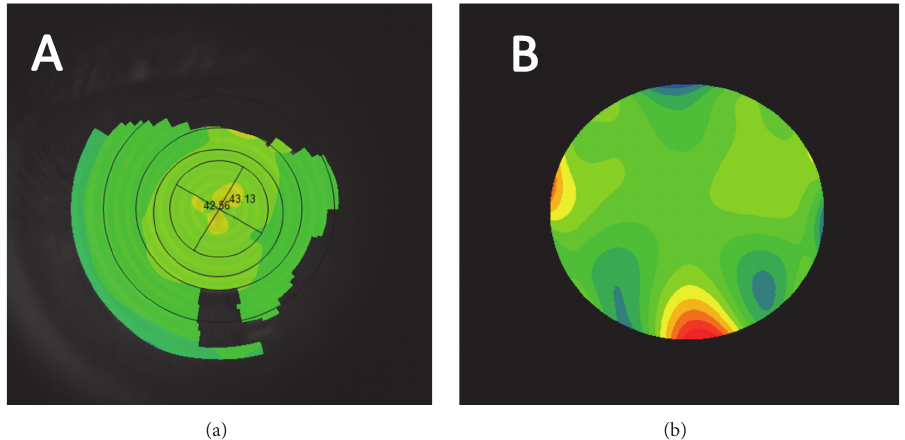
Figure 1: Example of corneal analysis provided by the VX120 system. (a) Axial corneal topographic map. (b) High-order wavefront aberration